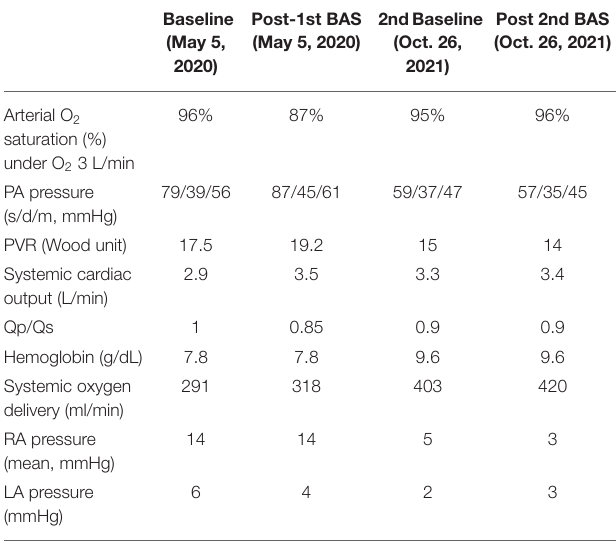
TABLE 1 | Hemodynamic parameters before and after balloon atrial septostomy in a patient with idiopathic pulmonary arterial